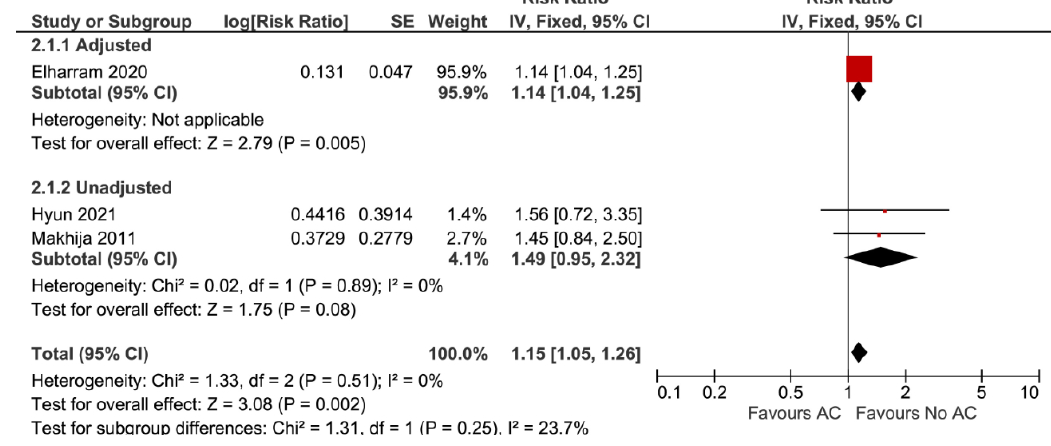
Figure 2: Forest plot for bleeding stratified by the use of multivariable adjustment. AC: anticoagulation.